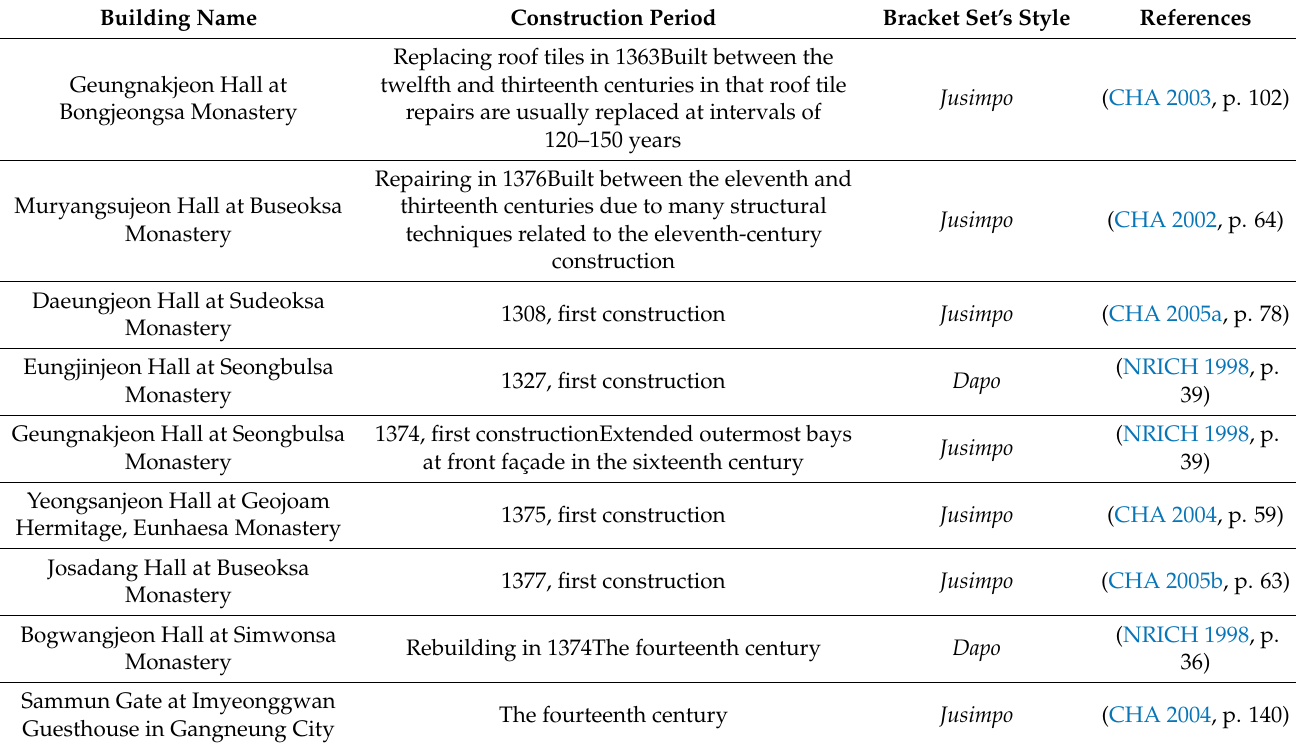
Figure 2. The distinction of Jusimpo ( left ) and Dapo ( right ) styles. ( Left : Muryangsujeon Hall at Buseoksa Monastery, Plate 18627, courtesy of National Museum of Korea; right: Bogwangjeon Hall at Simwonsa Monastery, Plate 18195, courtesy of National Museum of Korea). Table 1. Goryeo-era’s buildings in the Korean